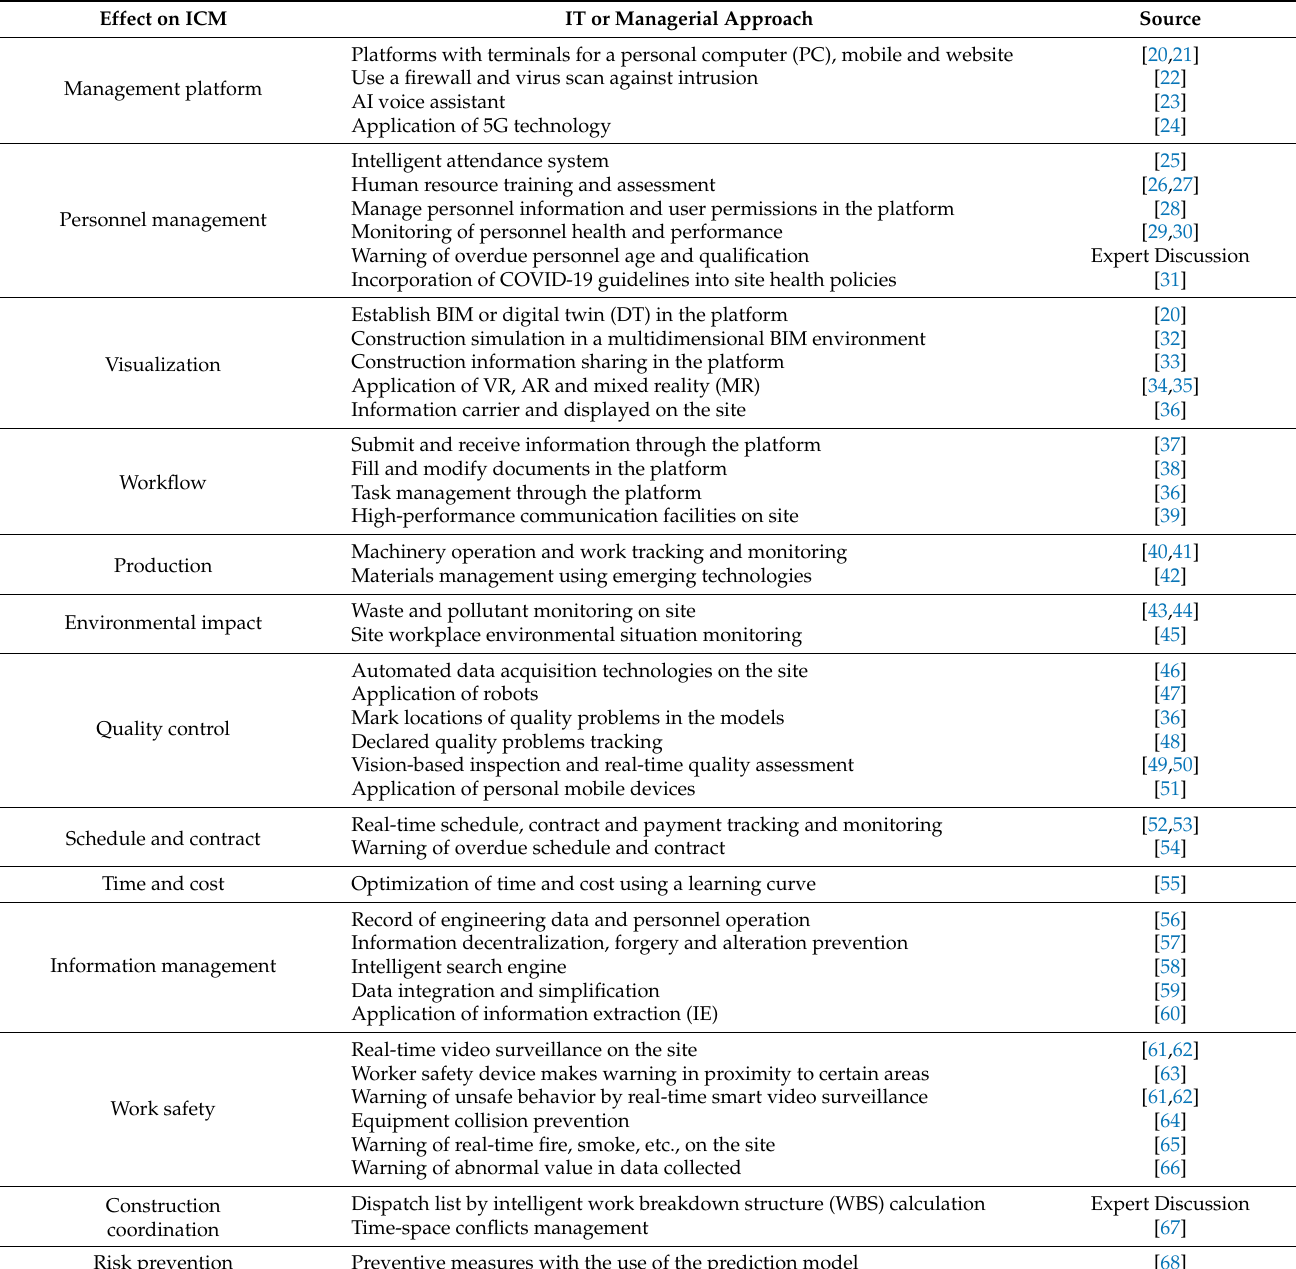
Table 1. IT or managerial approaches supporting